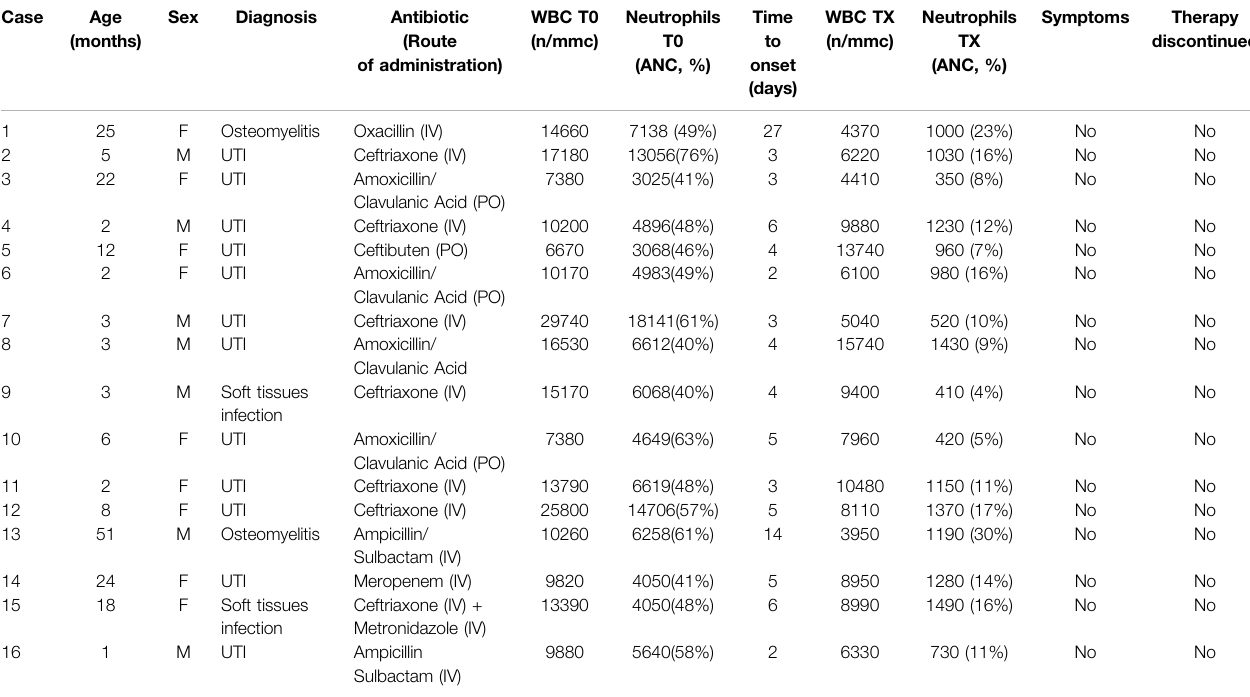
TABLE1| Anagraphiccharacteristicsoftheincludedpatients,detailsonantibiotictherapy,intermsofdrugandindicationuse,andvariationsintoANCandwhitebloodcells (WBC) count.